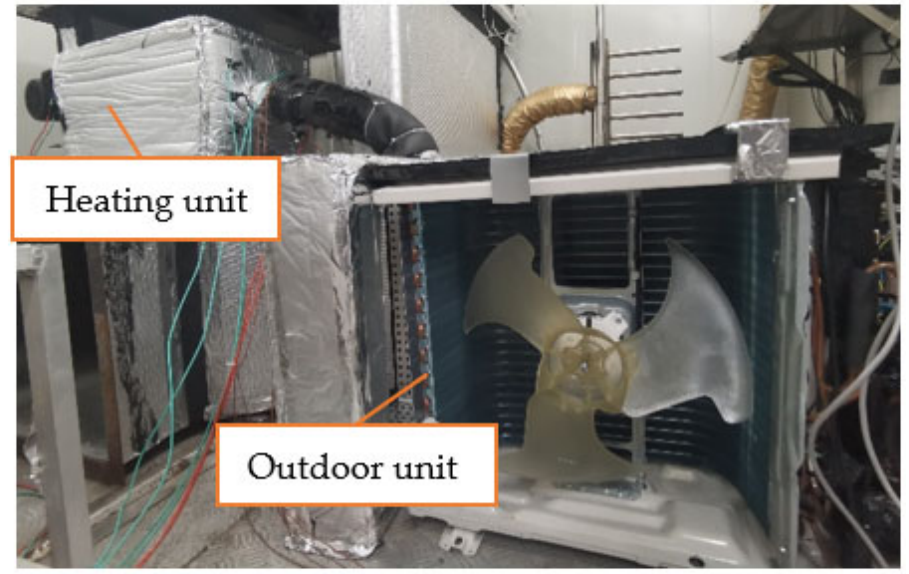
Figure 3. Physical picture of the outdoor unit of the SC-EVIHP system.